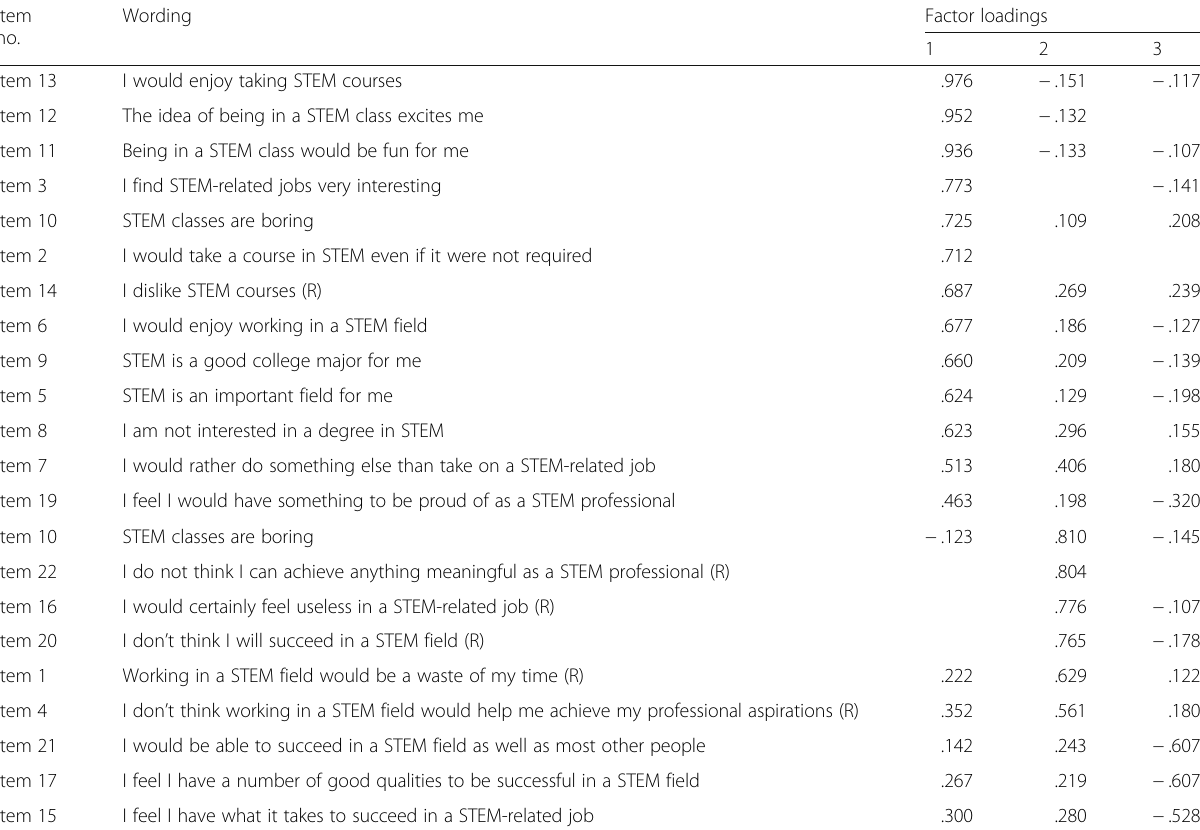
Table 7 Rotated factor loadings from the first factor